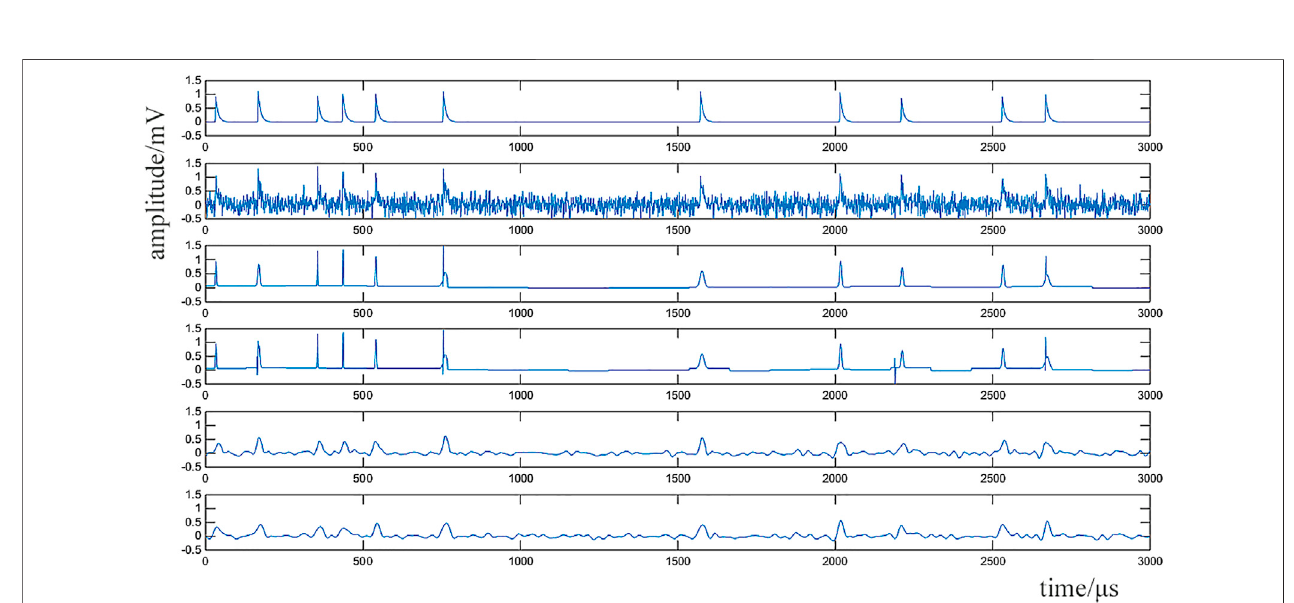
FIGURE 3 | Denoising results of the nuclear pulse simulation